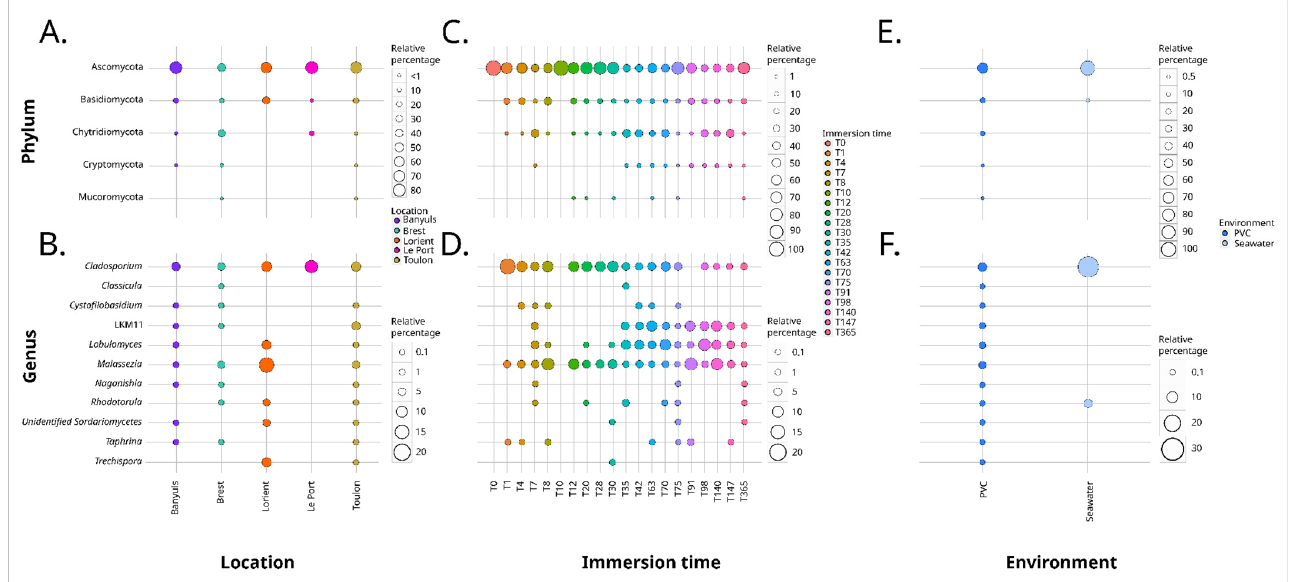
Figure 7. Bubble-plot representing the proportions of phyla or genus according to the variables ( A , B ) Location, ( C , D ) “Immersion time” (days), and ( E , F ) “Environment”. The listed genera correspond to the nine most abundant genera, also containing three genera identified as differentially abundant using ANCOM ( Cladosporium , LKM11 and Lobulomyces ), and two extra genera that were also highlighted by ANCOM ( Cysto fi lobasidium and Naganishia ).